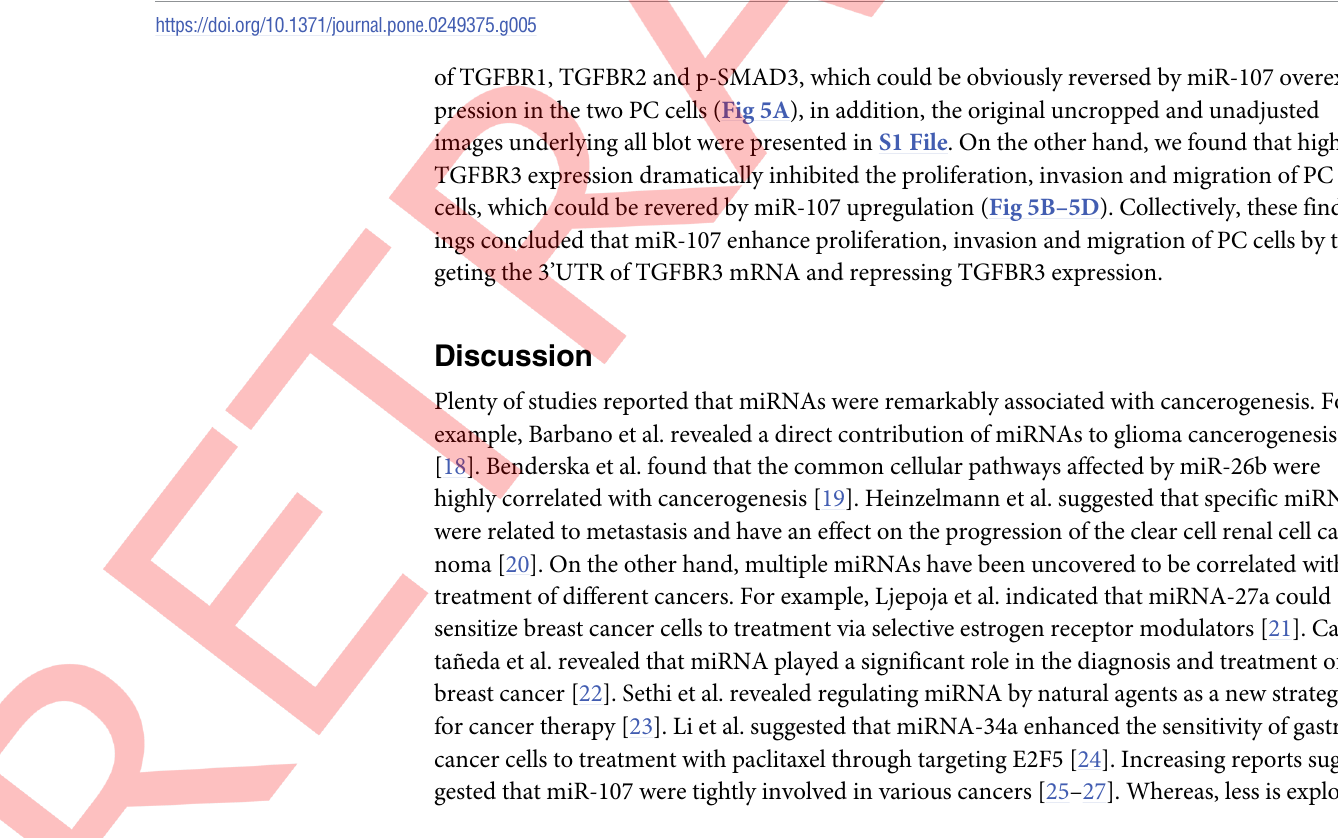
Fig 5. MiR-107 exerts its function role targeting TGFBR3. A, Expression of TGFBR3 was assessed via western blot and qRT-PCR analysis in BxPC-3 and PANC-1 cells. B, MTT assay exhibited the cell viability in BxPC-3 and PANC-1 cells. C, D, Transwell assay exhibited cell invasion and migratory performance of BxPC-3 and PANC-1